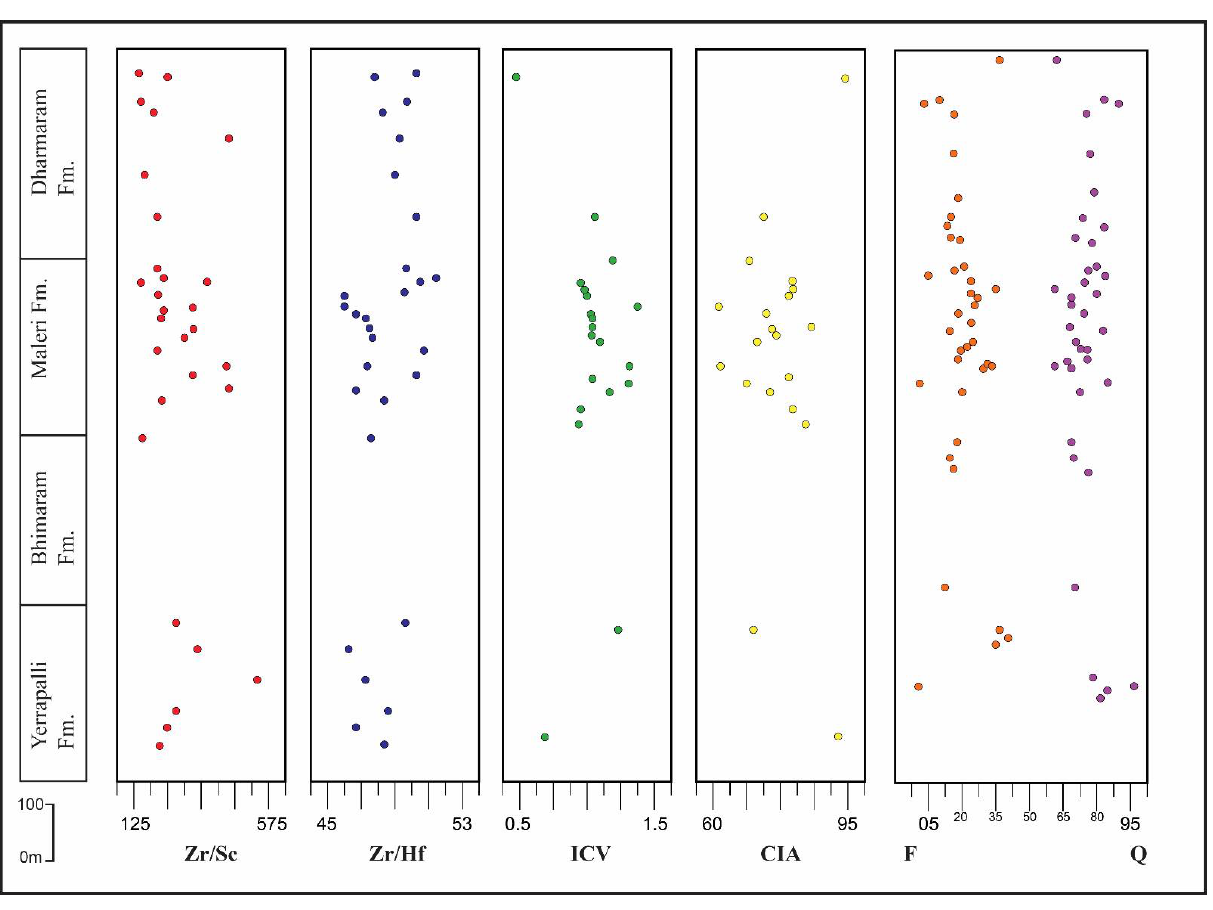
Figure 9. Variations of climate-sensitive proxies (Zr/Sc, Zr/Hf, ICV, CIA) across the Mesozoic formations of the Pranhita-Godavari Gondwana basin. The Zr/Sc content of the mudstones show a broadly similar trend despite minor variation, whereas Zr/Hf content shows a slight increasing trend from older to younger formations. Note that the mudstone samples with high CIA have low ICV (Orange for F and purple for Q in the last figure).